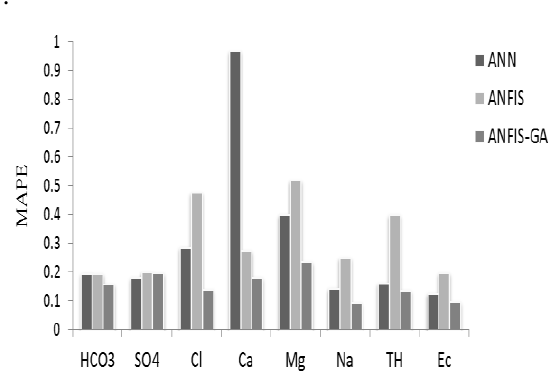
Figure 4. MAPE of chemical parameters analysis